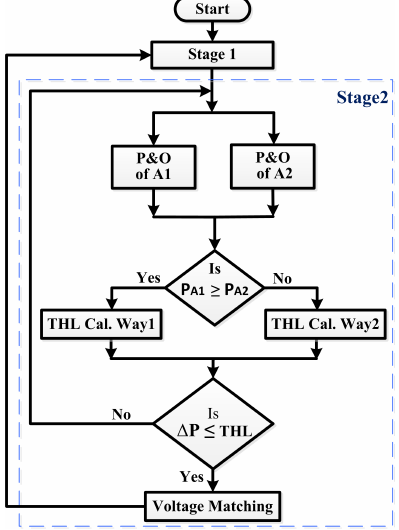
Figure 8. Flowchart of stage 2.